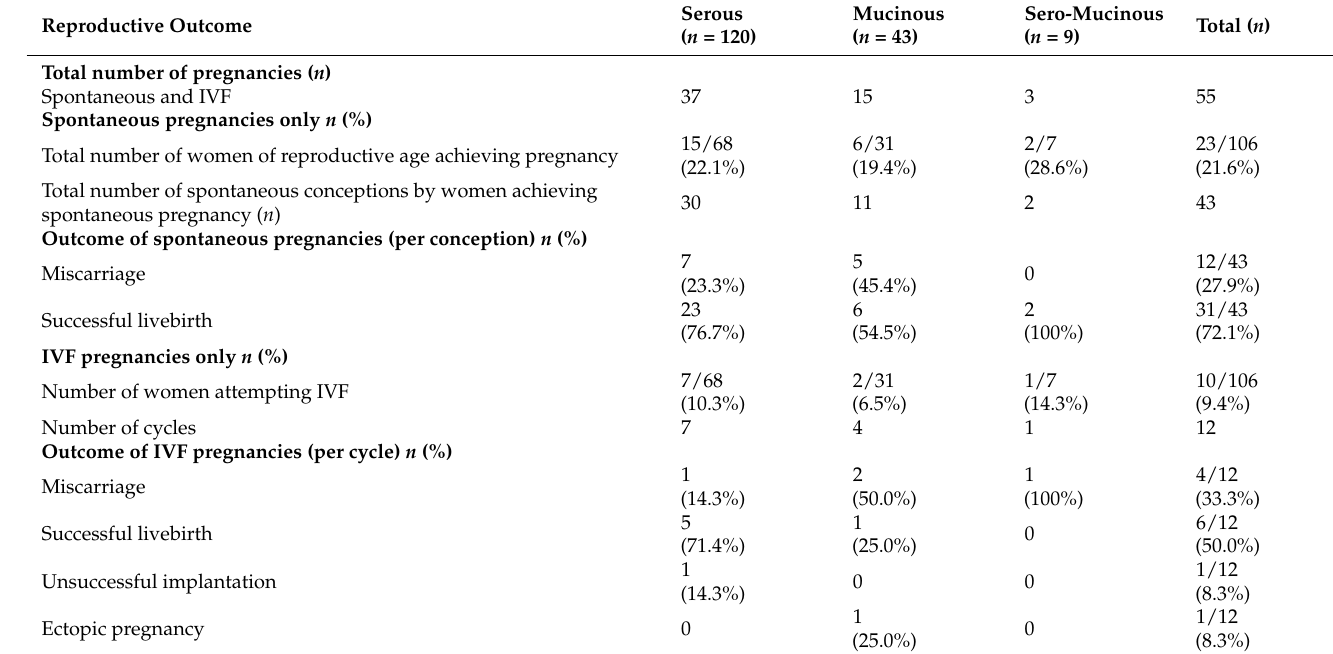
Table 7. Post-operative reproductive outcomes in women with Borderline Ovarian Tumour.